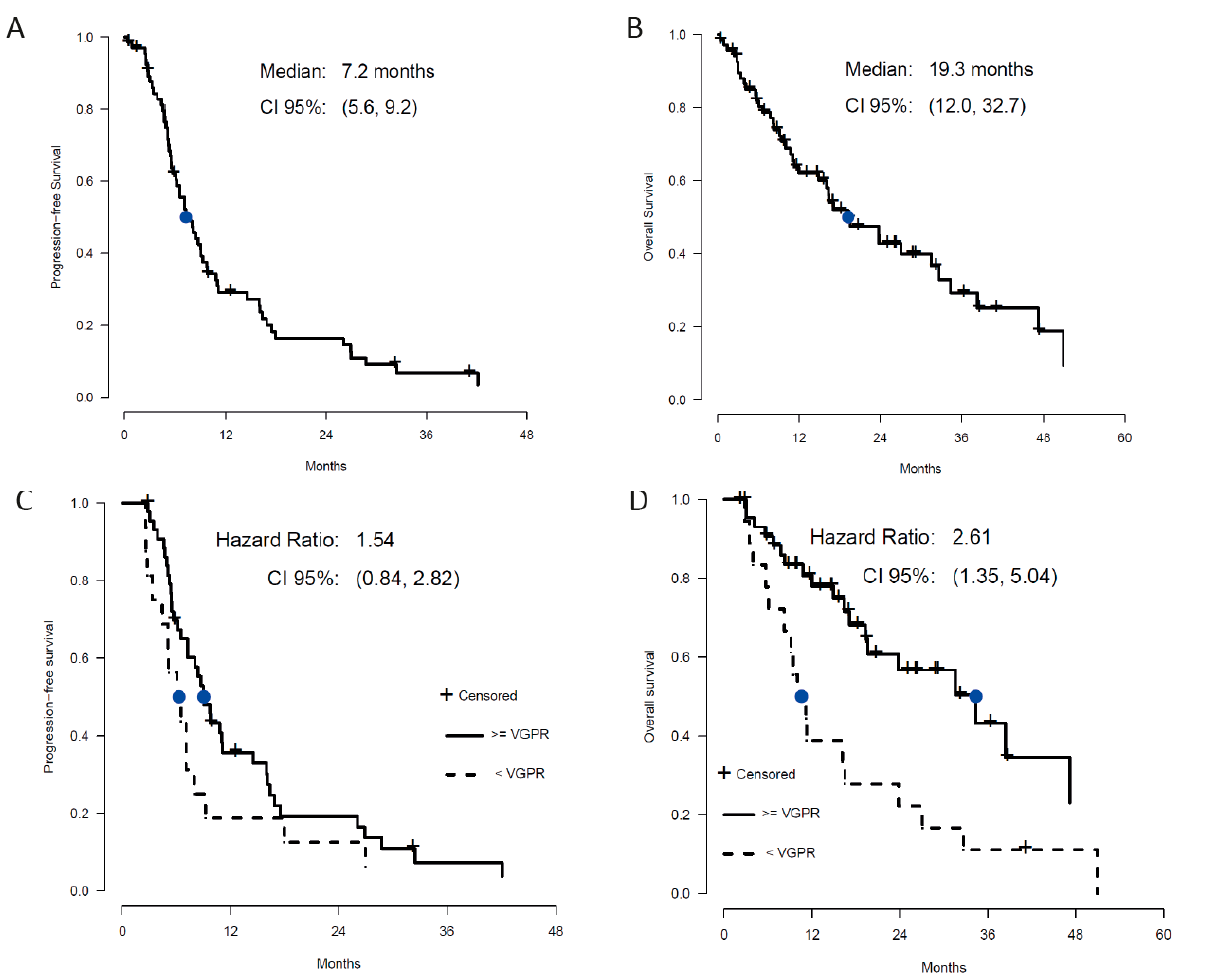
Figure 1. Median PFS ( A ) and OS ( B ) for the entire patient cohort. Clinical outcome stratified by response shows significantly better PFS ( C ) and OS ( D ) in patients who at least achieved a VGPR.